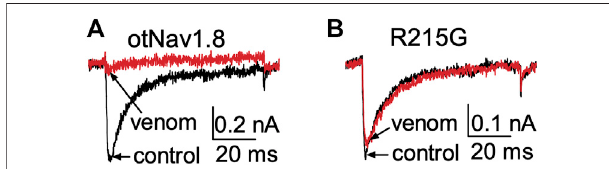
FIGURE 7 | Effects of AZ bark scorpion venom on Na + currents recorded from a DI S4 voltage sensor mutant. (A) Venom inhibits wildtype OtNav1.8 Na+ currents. (B) The fi rst GC arginine (R215) in the DI S4 voltage sensor was exchanged for a glycine (R215G). TTX (500 nM) was added tothebath solutiontoblockTTX-sensitivecurrents.Na + currentswereelicited by a 50 ms depolarization to +20 mV from a holding potential of − 80 mV before and after application of venom (10 μ g/ml). Venom inhibited wildtype